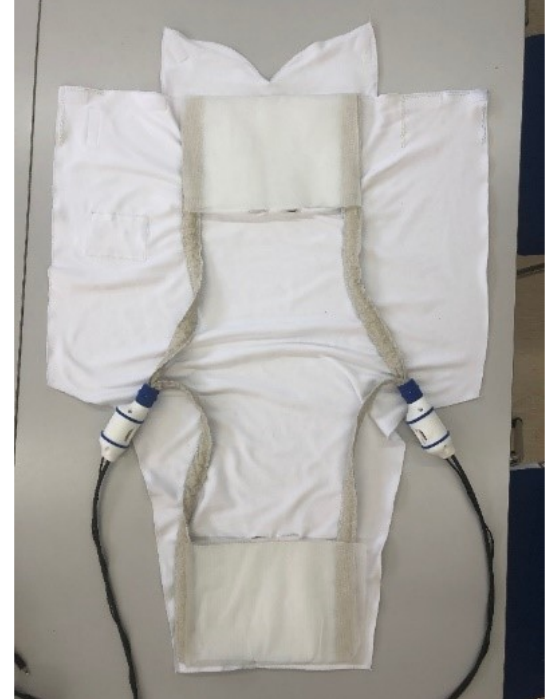
Figure 2. Light-emitting fabrics in the sleeping